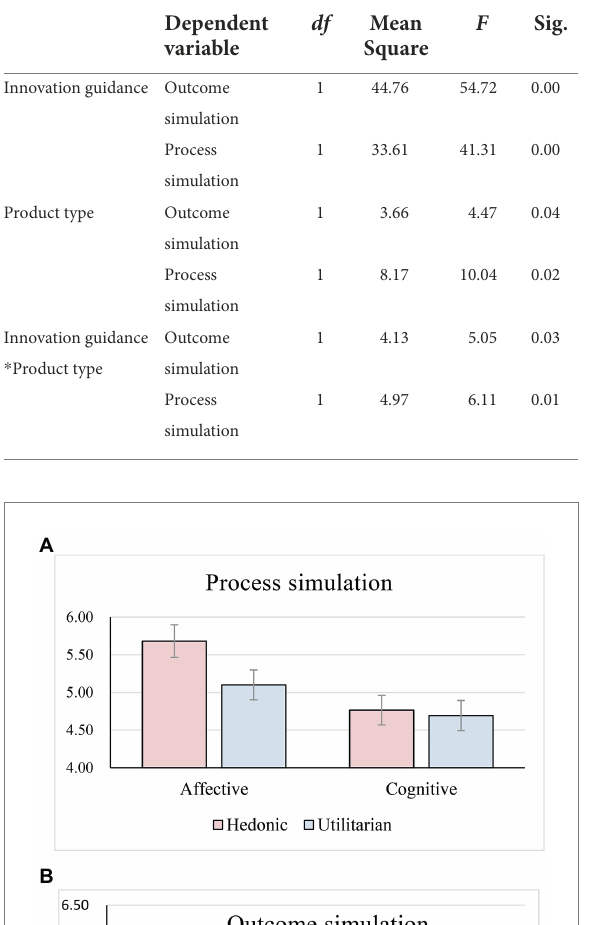
TABLE 4 ANOVA test—main and interaction effects.